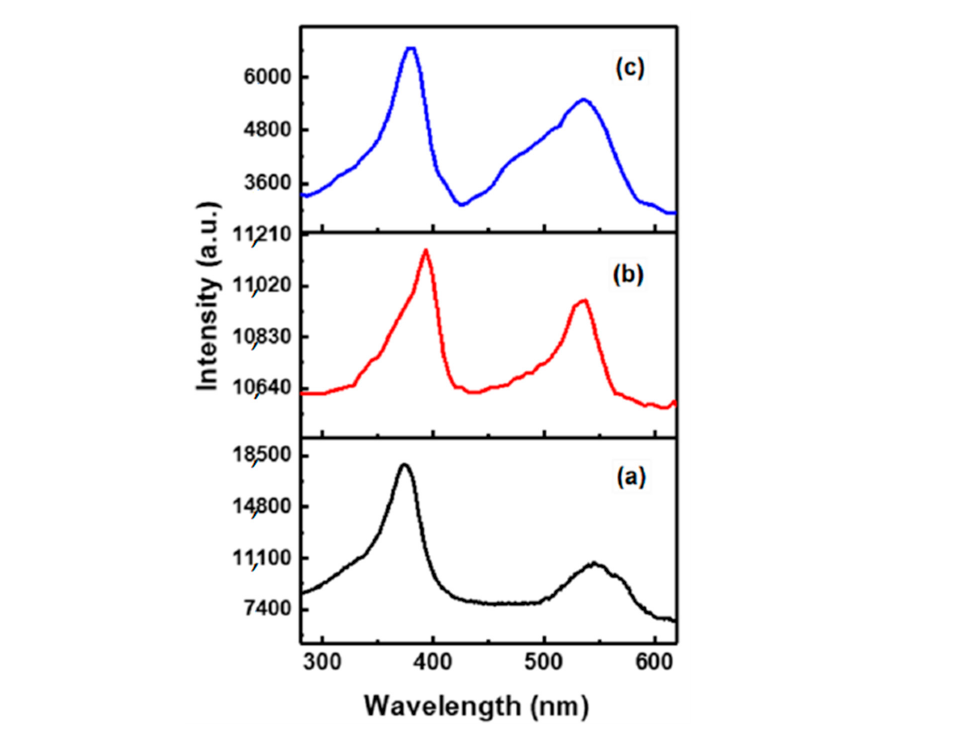
Figure 10. PL spectra for ( a ) ZnO, ( b ) TZO1, and ( c ) TZO2. Reproduced with permission from Ref. [32]; published by Springer Nature, 2018.